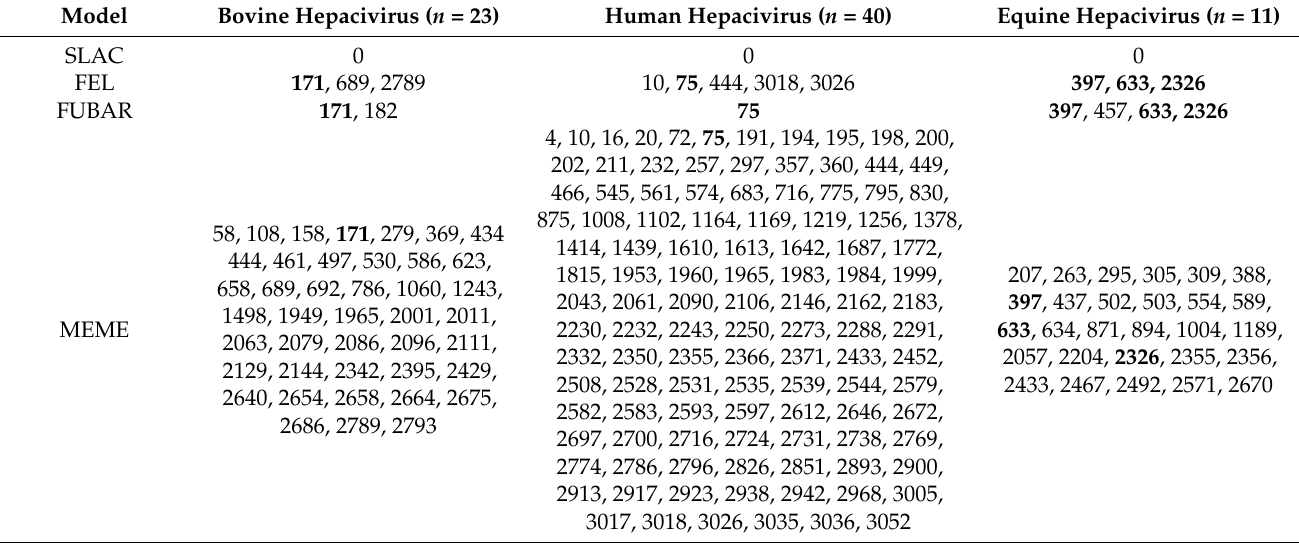
Table 4. Prediction of putative positive selection site of hepacivirus genome from different